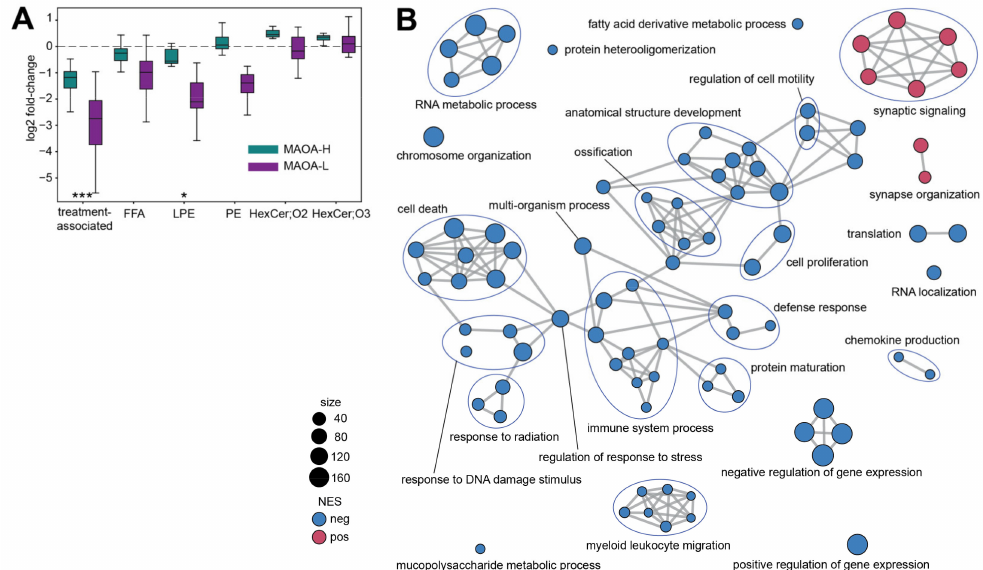
Figure 3. ( A ) Base two log-transformed fold-change (log2 FC) values calculated between treated and control animals carrying MAOA-H (green) and MAOA-L (purple) genotype. X-axis labels indicate lipids used in the comparison: 106 treatment- associated lipids and lipids contained in treatment-affected lipid classes: FFA, LPE, PE, HexCer;O2, and HexCer;O3. Boxes show median log2 FC values and interquartile interval. Error bars extend according to Tukey’s original boxplot definition. Asterisks indicate enrichment in lipids showing treatment-by-MAOA genotype interaction (hypergeometric test, *** p < 0.001, * p < 0.05). ( B ) Gene ontology (GO) terms enriched in gene expression differences between treated and control animals (GSEA, adjusted p < 0.05). One point indicates one GO term. Colors show negative (blue) and positive (red) normalized enrichment score values, which correspond to the dominant direction of expression change between treated and control animals within the GO term. Symbol size is proportional to the number of genes in the GO term. Edges connect functionally related GO